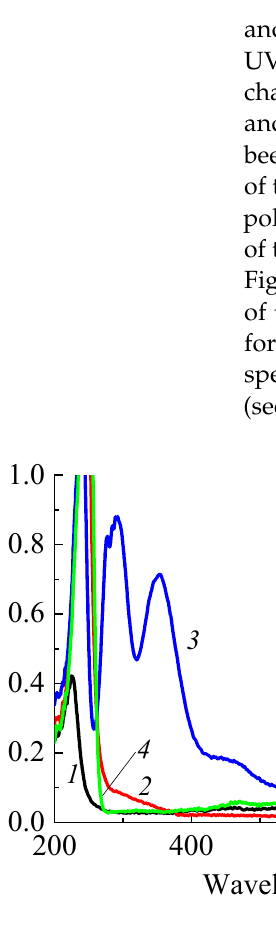
Figure 1. Representative UV–Vis spectra obtained for ( a ) individual components of the synthesis: 1—1.5 mM CuSO 4 , 2—10 mM Py, 3—0.5 mM I 2 , 4—3 mM KI; ( b ) the multiple mixture at the initial (1) synthesis time and after a complete reaction route (shown for the sample 4 as a case study): 2—1 h, 3—2 h, 4—3.5 h, 5—after 5.5 h, 6—24 h.